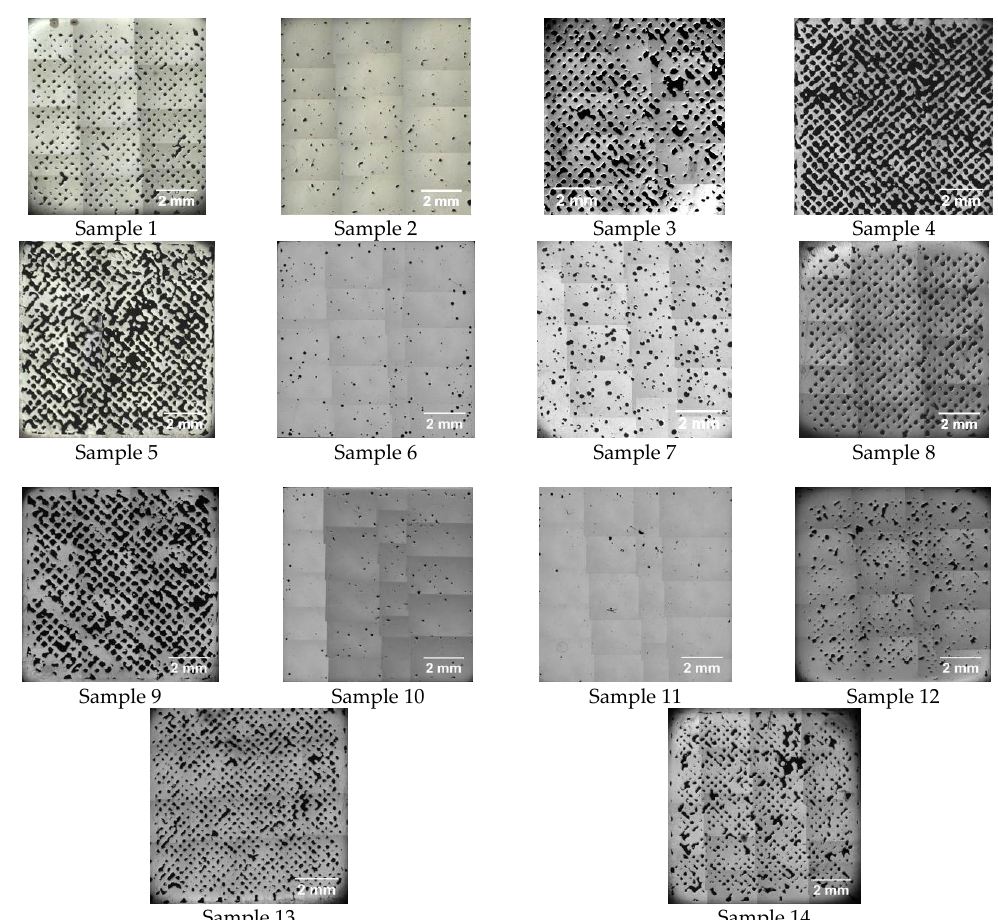
Figure 3. Merged micrographs of the cross-section of AlSi10Mg selective laser melted (SLMed) samples.